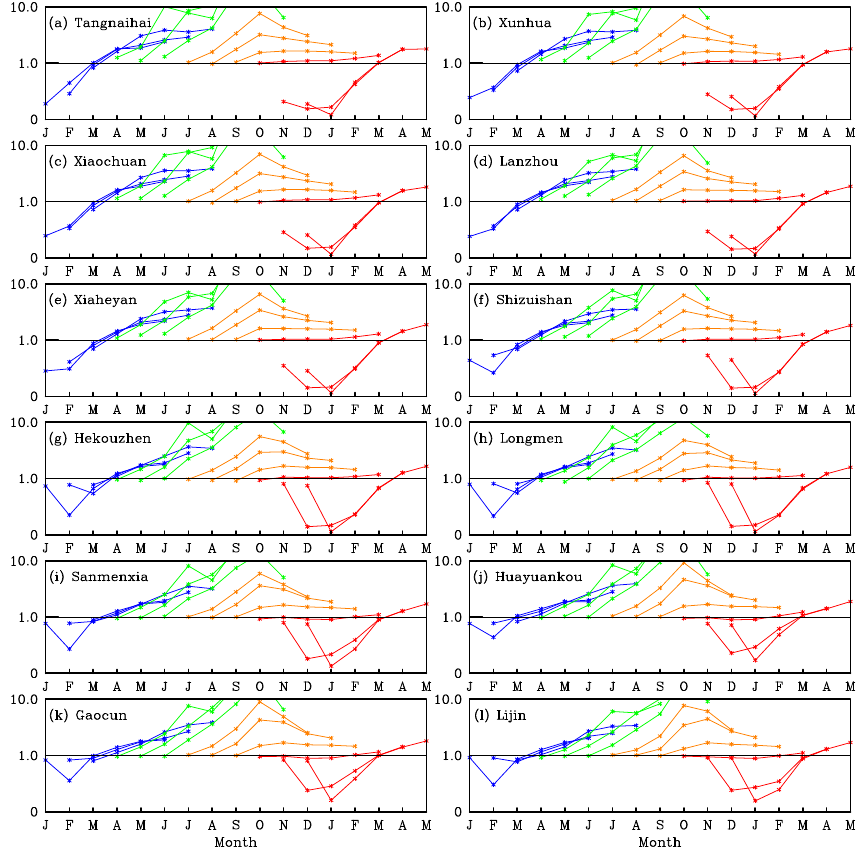
Figure 6. The same as Fig. 5 but for the ESP simulations without the initialization of the routing